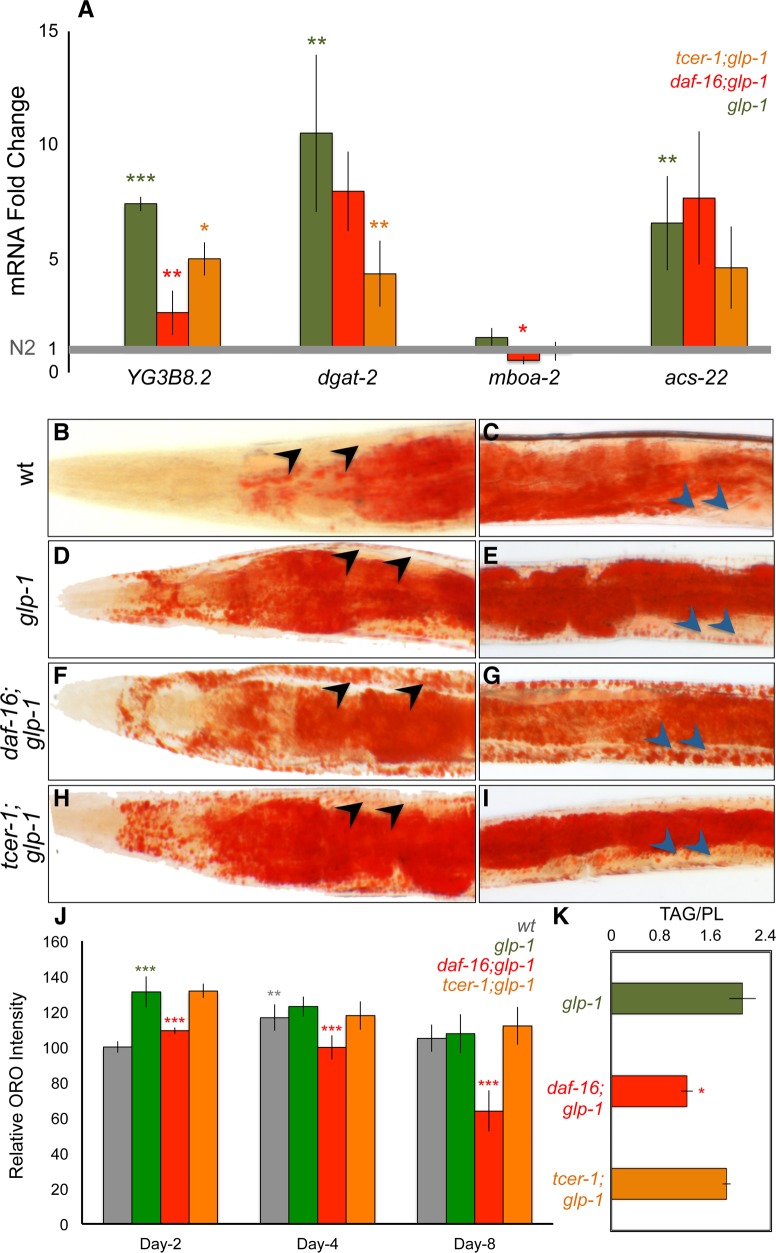
A. DAF-16 and TCER-1 mediate, in part, the increased expression of genes involved in triglyceride (TAG) production following germline removal. mRNA levels of genes encoding diacylglycerol acyl transferase (DGAT) enzymes that catalyze TAG production, compared relative to wild-type (N2, gray bar normalized to 1), between glp-1 (green), daf-16;glp-1 (red) and tcer-1;glp-1 (orange) day 2 adults by Q-PCR. B-J. daf-16;glp-1 mutants exhibit ectopic lipid deposition and undergo a progressive depletion of lipid stores with age. Lipid levels compared between different strains by ORO staining adults on days 2, 4 and 8 of adulthood. Representative images are shown in B-I and quantification is in J. The images focus on head region (B, D, F and H) and mid-body (C, E, G, I) of wild-type (N2, B, C) glp-1 (D, E), daf-16;glp-1 (F, G) and tcer-1;glp-1 (H, I) day 6 adults. daf-16;glp-1 mutants showed reduced ORO staining on day 2, as compared to glp-1. While N2 worms exhibit increased intestinal ORO after day 2, daf-16;glp-1 mutants continue to undergo reduction in ORO levels. They also exhibit large, ectopic lipid droplets in muscle cells that are not observed in other strains (compare arrowheads between F, G and other panels). J:
daf-16;glp-1 mutants show decreased TAG levels.Using GC/MS, the triglyceride: phospholipid (TAG/PL) ratio of day 2 daf-16;glp-1 adults was found to be significantly lesser than that of age-matched glp-1 animals. tcer-1;glp-1 mutants did not exhibit reduction in ORO staining nor biochemical TAG depletion, despite promoting the upregulation of DGAT genes. In A, J and K, asterisks represent the statistical significance of differences observed in an unpaired, two-tailed t-test with P values 0.05 (*), 0.005 (**) or < 0.0005 (***). Green asterisks indicate the comparison between N2 and glp-1 whereas, red and orange asterisks depict the comparisons between glp-1 and daf-16;glp-1 or tcer-1;glp-1, respectively. The gray asterisks in J (day 4, N2 bar) show the comparison between N2 ORO levels on days 2 vs. 4. Error bars represent the standard error of the mean.